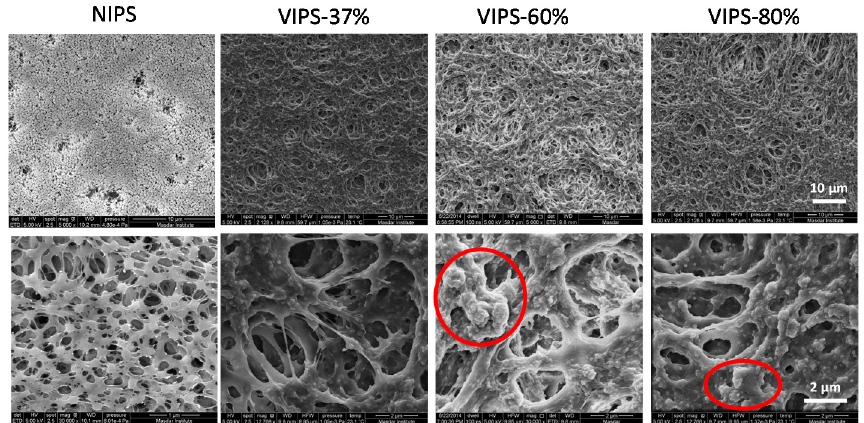
Figure 1. Top surface scanning electron microscope (SEM) images of membranes prepared using NIPS (non ‐ solvent ‐ induced phase separation) and VIPS (vapor ‐ induced phase separation) processes with 12% w / w PVDF (Polyvinylidene fluoride) concentration and cast thickness of 500 μ m (10 μ m and 2 μ m scale bares for all top and bottom row SEM images, respectively).